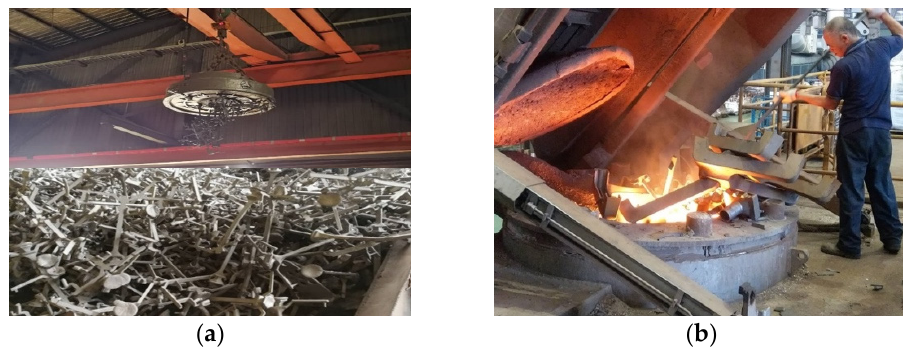
Figure 5. ( a ) The manual slag removal action; ( b ) the raw material is manually pushed into the